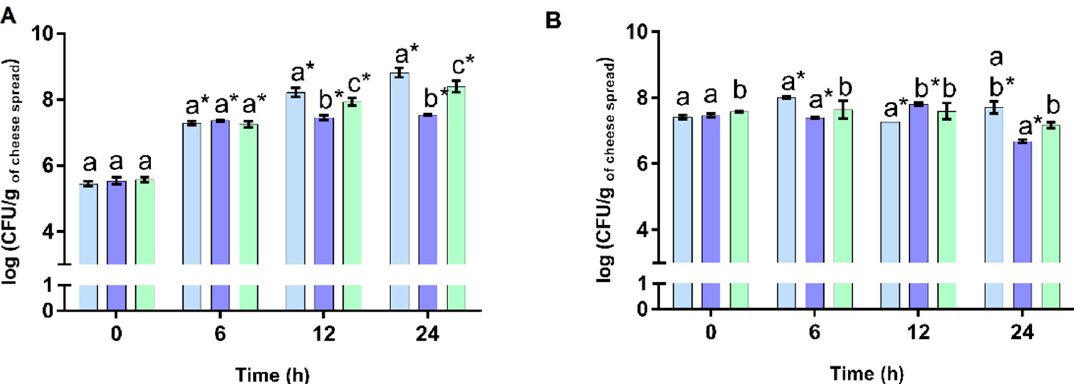
Figure 2. Evolution of viable cell numbers of Lactobacillus acidophilus LA-5 ® ( A ) and those of Bifidobacterium animalis subsp lactis BB-12 ® ( B ) in the cheese spread incorporated with Osmundea pinnatifida (CSExt, shown by the blue bar), the plain cheese spread (CS, shown by the purple bar), and the cheese spread with FOS (CSFos, shown by the green bar) upon manufacture (0 days), incubated over 24 h at 37 ◦ C. Different letters indicate statistically significant differences ( p < 0.05) between the three cheese spreads at each sampling time, while bars marked with * means statistically significant differences ( p < 0.05) in comparison to the data obtained at 0 h.